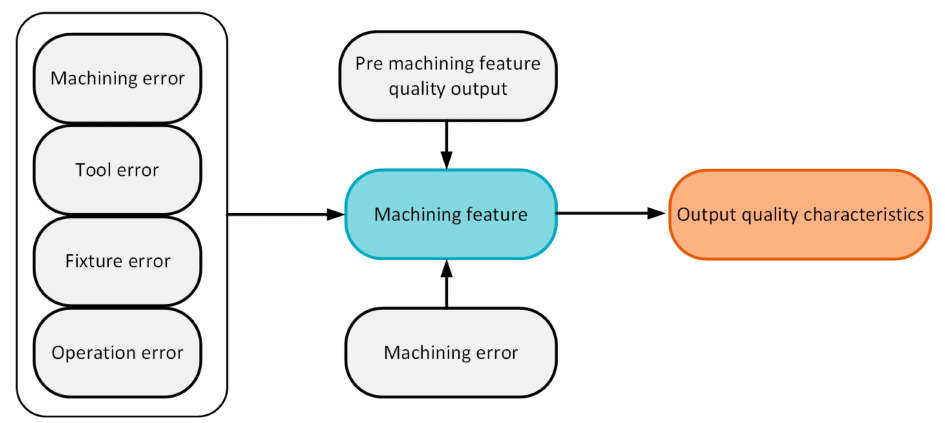
Figure 7. Schematic diagram of the diesel engine body machining quality prediction